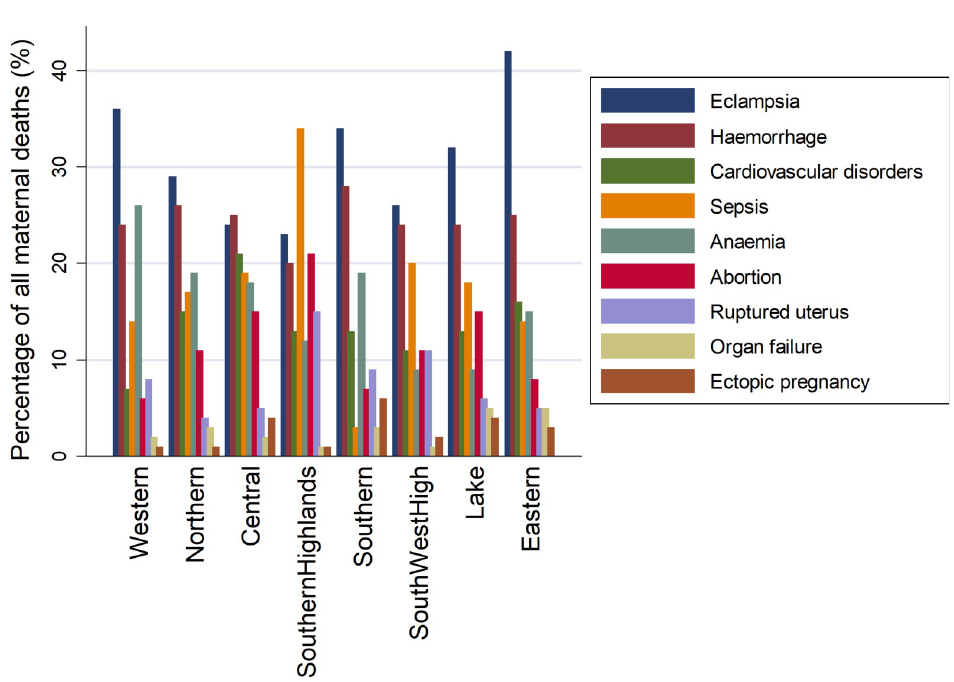
Fig 11. The distribution of major causes of maternal deaths by zone (n = 1,987).